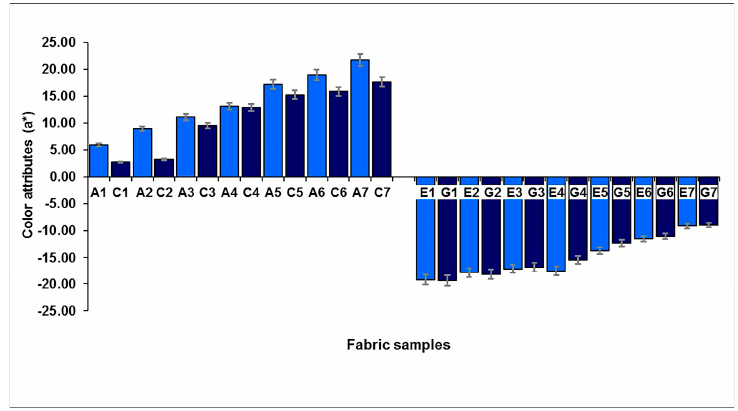
Figure 7. Effect of weft-backed structure on the redness and greenness of blue-red and yellow-green mixed fabrics. Polymers 2018 , 10 , x FOR PEER REVIEW